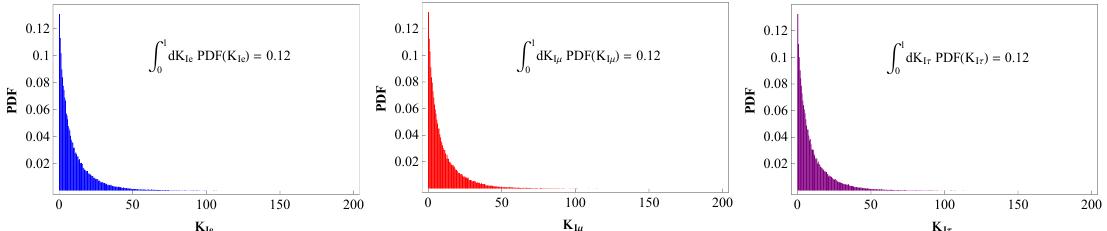
Figure 5. Distributions of the decay parameters for m 1 = 0 and generic values of the mixing from a random (cid:13)avour blind generation of U and